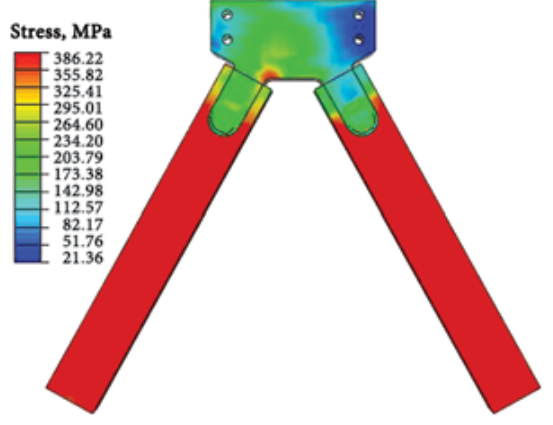
Fig. 14. Mises color stress cloud chart of steel member